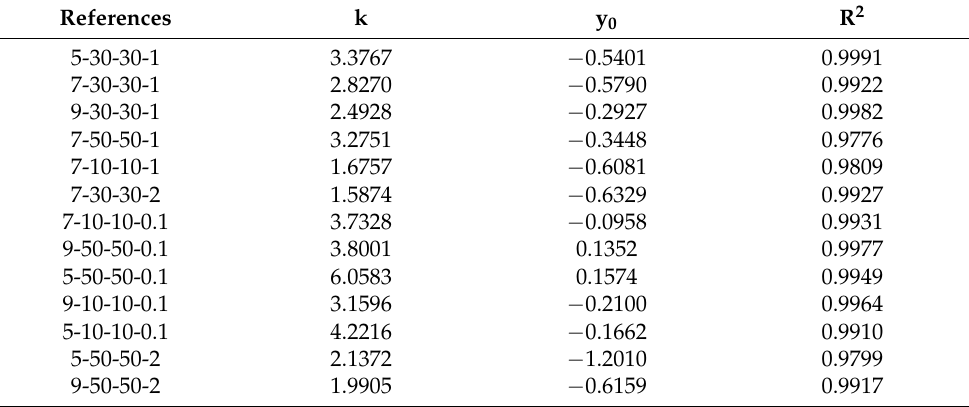
Table 2. Experimental conditions and parameters obtained with the first-order kinetic adjustments.